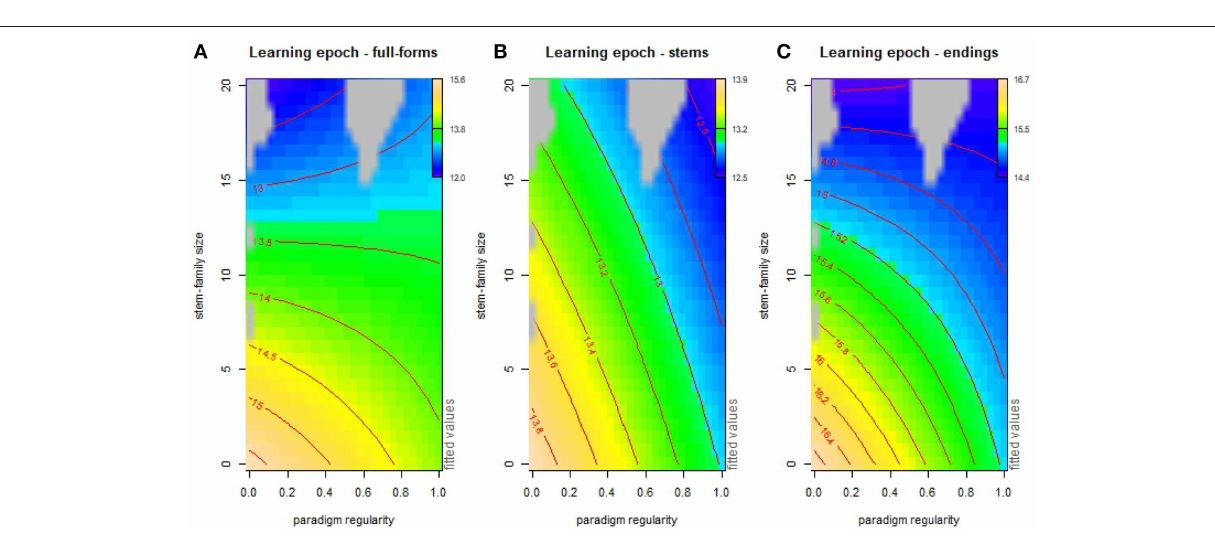
FIGURE 12 | Contour plots of additive interaction effects of stem-family size and paradigm regularity on word (A) , stem (B) , and ending (C) learning. Grid points at a distance of ≥ 0.2 from the predictor variables are excluded (gray